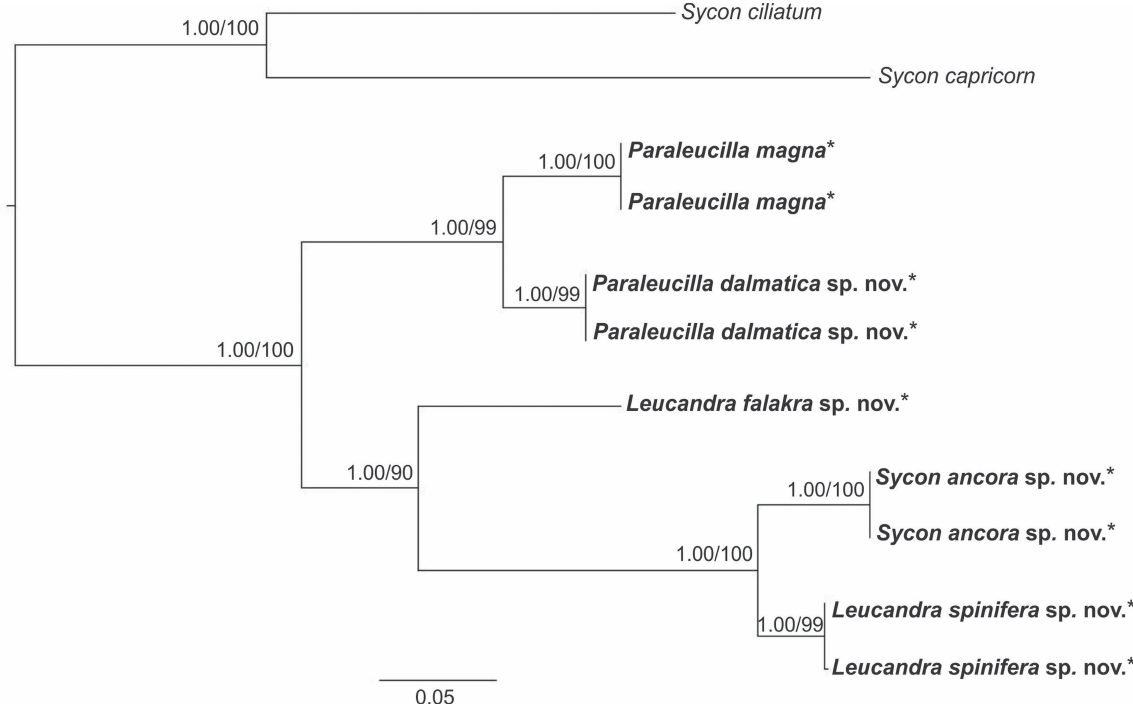
Fig. 18. Maximum likelihood tree based on ITS1-5.8S-ITS2 rDNA sequences of Calcaronea. Bayesian posterior probabilities (PP) and bootstrap values (BS) are given near the branches (PP/BS; when >0.50). Adriatic species are written in bold. Adriatic specimens obtained in this study are marked with an